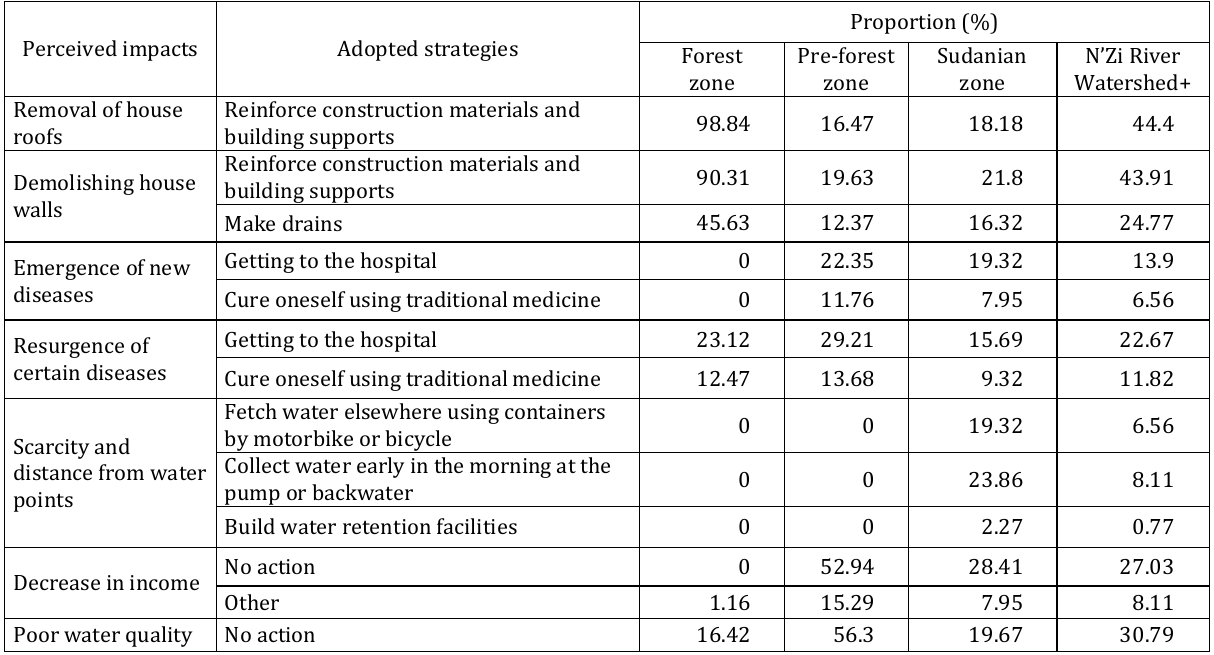
Table 8. Adaptation strategies developed against the perceived impacts of climate change on humans and their habitat